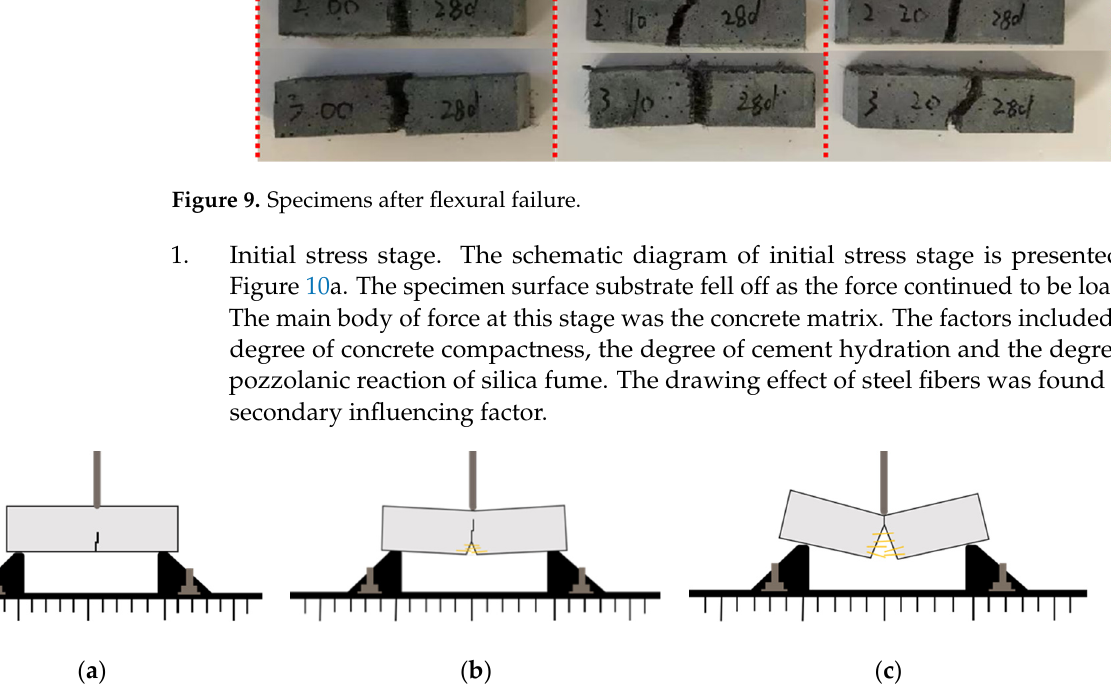
Figure 10. Schematic diagram of the bending resistance stage of the specimen. ( a ) Initial stress stage; ( b ) Stress enhancement stage; ( c ) Ultimate failure stage.